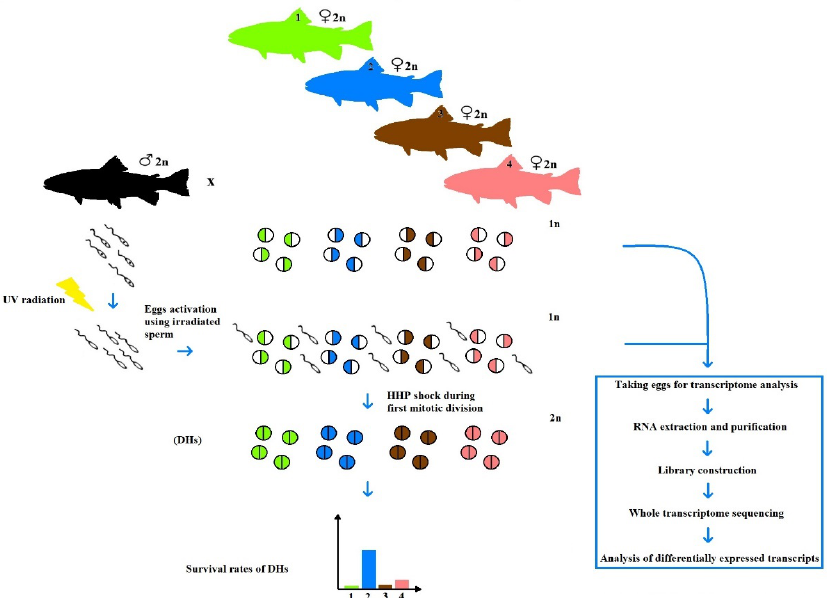
Figure 1. Scheme of the experimental design to produce gynogenetic doubled haploids (DHs) in rainbow trout and to perform the transcriptome analysis of eggs that show different ability for gynogenetic development. UV- irradiated spermatozoa were used to activate eggs and high hydrostatic pressure (HHP) shock was applied to duplicate maternal